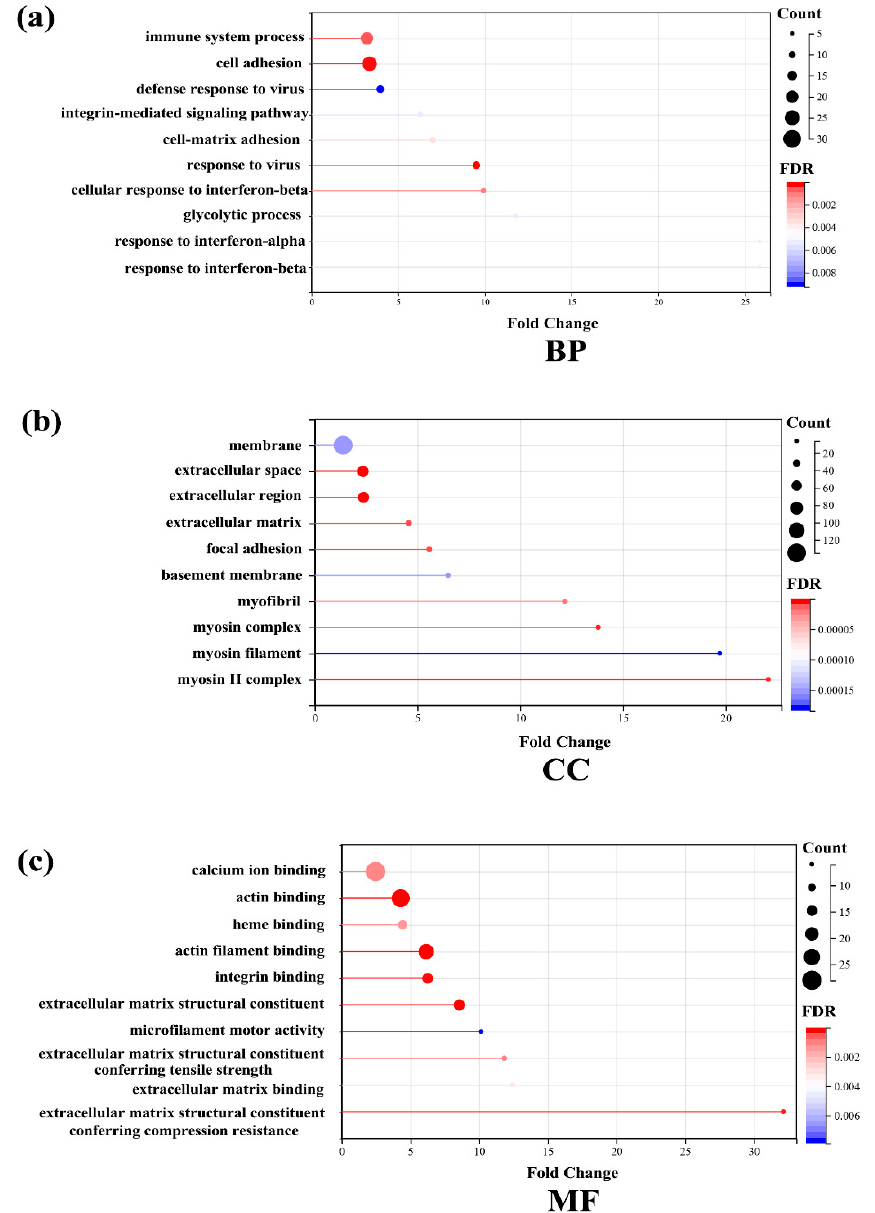
Figure 3. The top 10 gene ontology (GO) analyses of liver proteins. Proteins were classified according to ( a ) the cellular component (CC), ( b ) the biological process (BP) and ( c ) the molecular function (MF) by DAVID (2021 version).